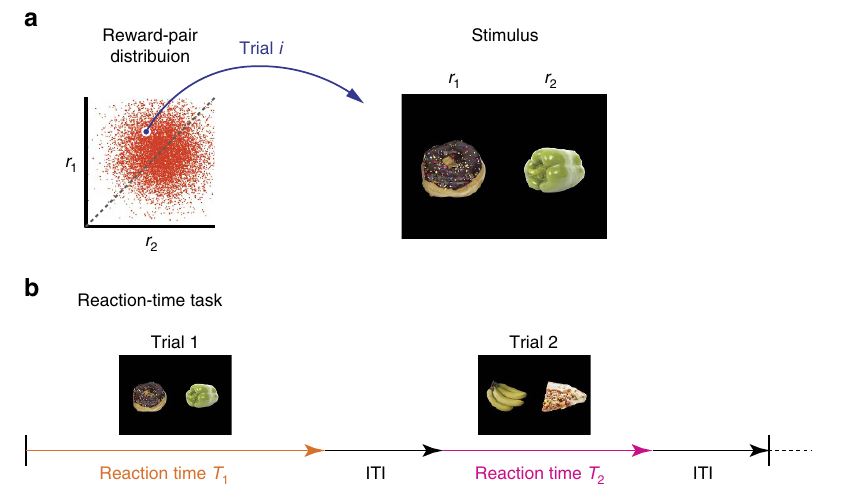
Figure 2 | Typical value-based decision-making task. ( a ) (left) Prior distribution from which the rewards for a pair of options are sampled. r 1 and r 2 indicate the reward magnitudes for individual options (for example, objects presented on left- and right-hand side of the screen in each trial). (right) A typical visual stimulus in each trial. ( b ) Reaction-time task. In each trial, the decision maker is presented with a pair of options. The decision maker reports her choice as soon as she has decided which of the two options she prefers. The reaction time ( T i ) can vary among trials, and individual trials are separated by a fixed inter-trial